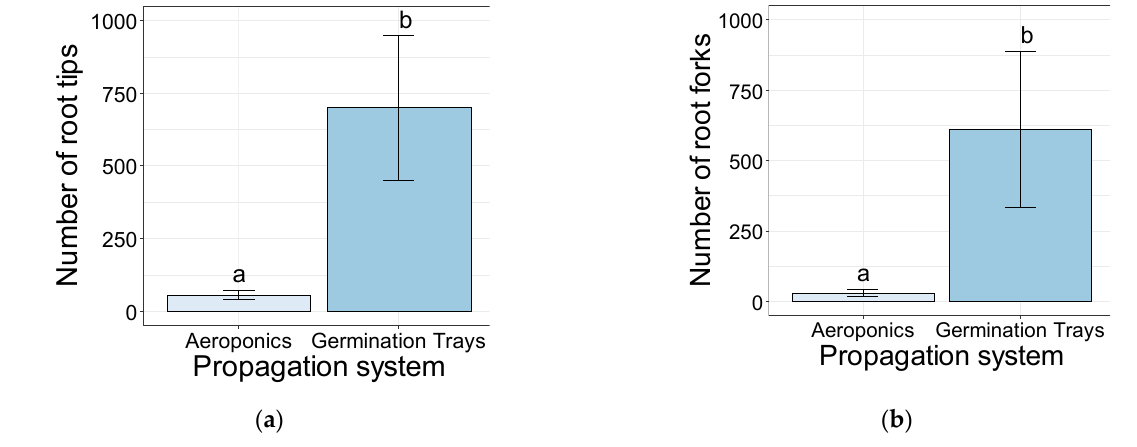
Figure 5. Number of roots tips ( a ) and number of root forks ( b ) of the softwood cuttings after 35 days of rooting, established in aeroponics systems and germination trays. Bars bearing the different letters are significantly different at p ≤ 0.05.